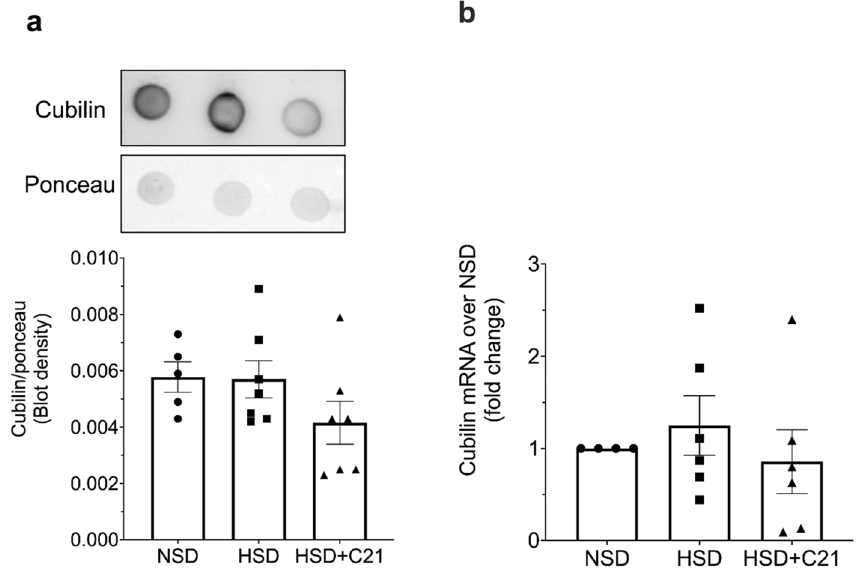
Figure 3. Expression of cubilin through dot blot ( a ) and mRNA expression of cubilin ( b ). Densitometry was normalized by ponceau ( a ). Values are represented as mean + sem; one-way ANOVA followed by Fisher’s LSD test